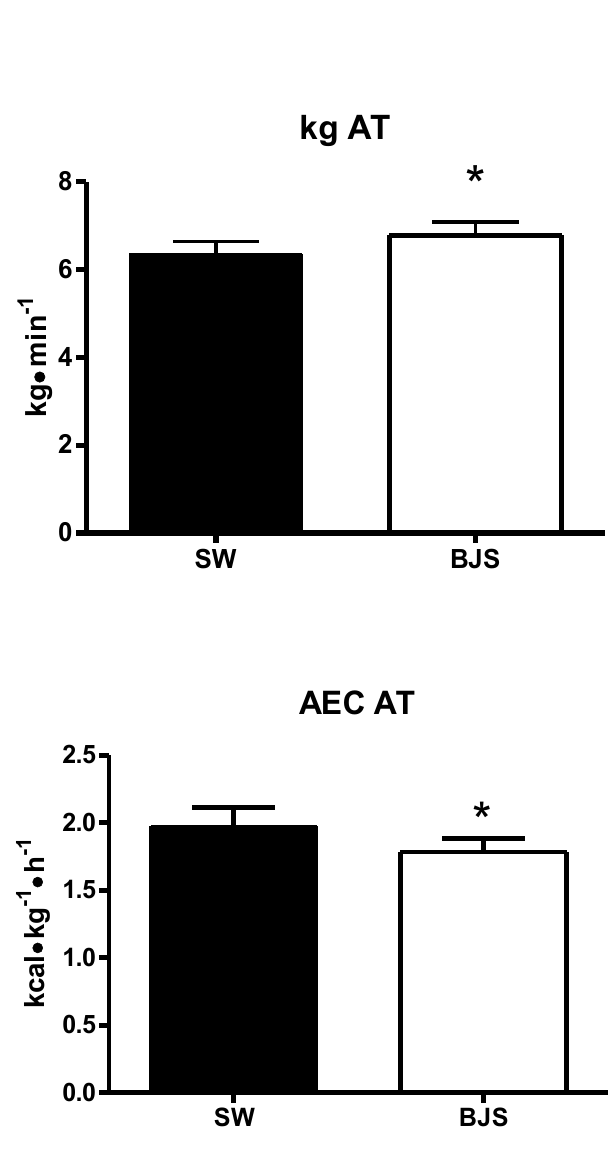
Figure 2. Upper panel: workload at anaerobic threshold (kg AT panel: aerobic energy cost at anaerobic threshold (AEC AT). CSW = control swimming test; BJS = beetroot juice supplementation test. * = p < 0.05 vs. the CSW